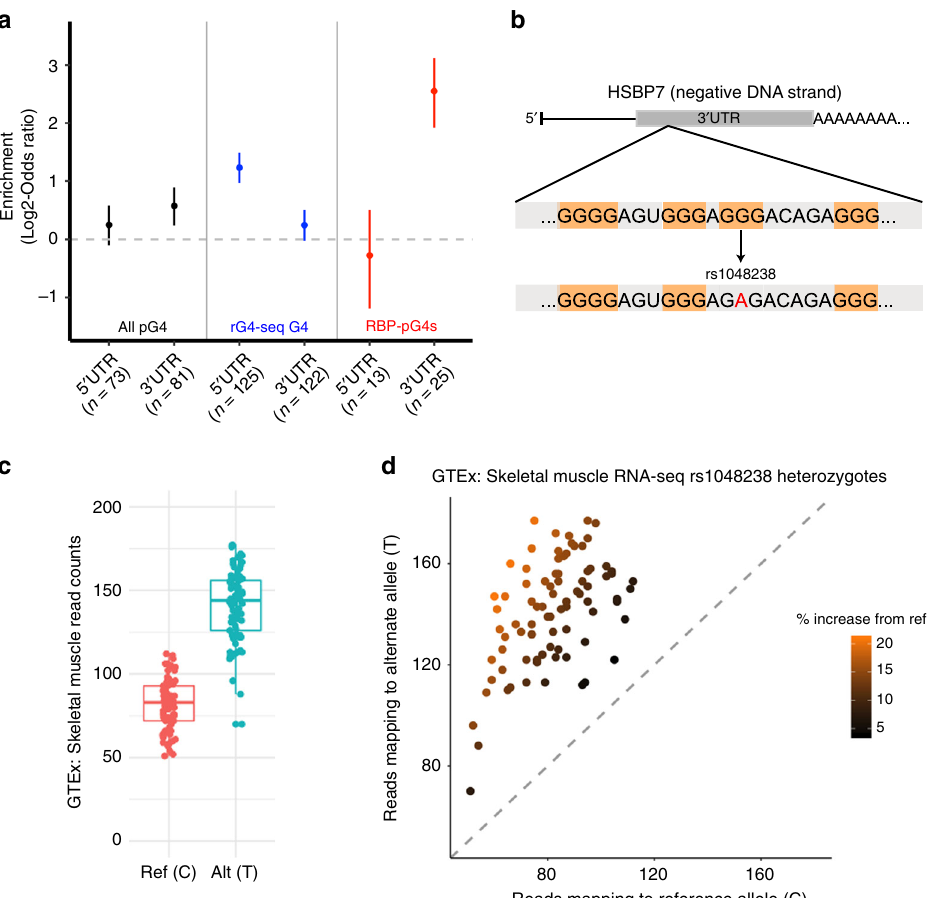
Fig. 5 UTR pG4 sequences are enriched for known pathogenic, and putative disease-associated genetic variants. a Annotated variants within ClinVar disease-associated genes occur with greater frequency in UTR pG4 sequences compared to non-pG4 UTR regions in the 3 ′ UTR across multiple G4 subsets (error bars represent the 95% con fi dence interval). b rs108348 maps to a 3 ′ UTR pG4 G-tract guanine within the primary HSPB7 transcript, which is encoded on the negative DNA strand. The SNP disrupts the canonical G4 sequence motif by causing a G to A mutation in the RNA transcript. c , d WASP-mapping of allele-speci fi c reads in 84 GTEx skeletal muscle samples reveals signi fi cant allelic imbalance favoring expression of the alternative allele ( P value < 1 x 10 − 100 , likelihood ratio test). Boxplot in c represents median and 1.5 times the interquartile range of WASP-aligned RNA-seq reads aligning to the ference (red) or alternative (blue) allele. Source data are provided as a Source Data fi